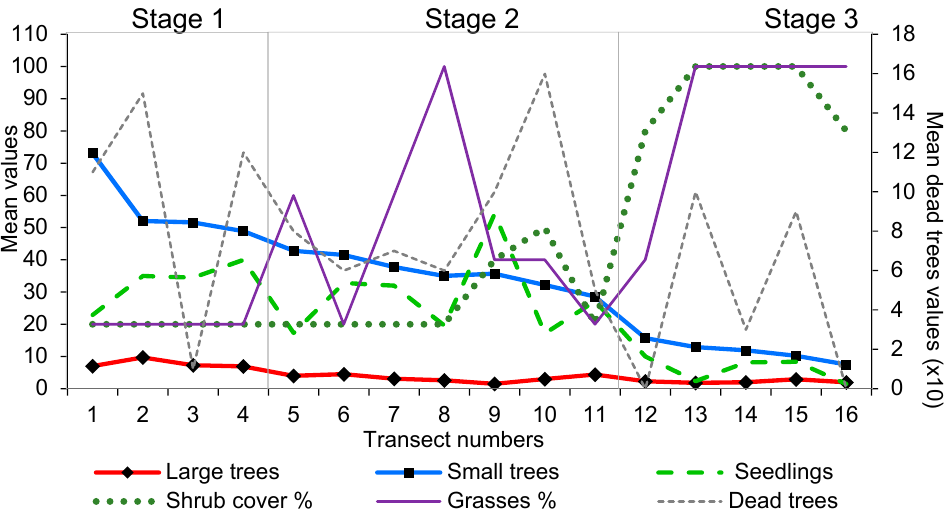
Figure 7. Graph of the data from Table 1 showing the inter-relationship of the six main factors across the three stages.